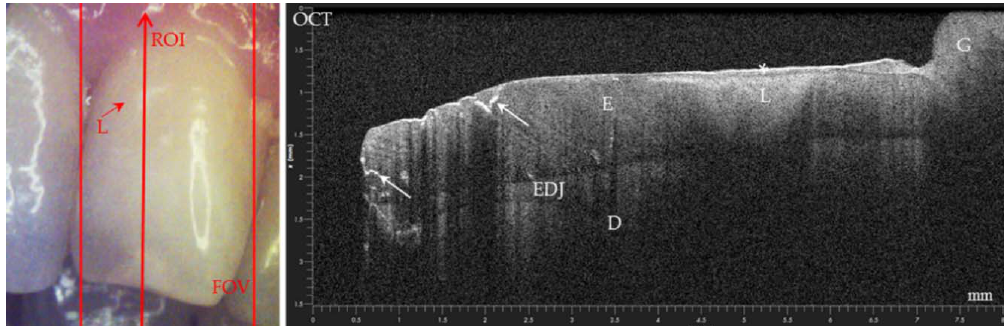
Figure 2. Screenshot, in vivo image of a human incisor. Partial conformance of visual assessment with OCT. A carious lesion (L) of ICDAS II Code 2 can be detected visually at the air ‐ dried enamel surface (red arrow). In the SD ‐ OCT B ‐ scan, this lesion appears as a bright shadowed area without cavitation. Compared to visual assessment, the OCT signal reveals an extended lesion body with dentin (D) involvement and a mineral ‐ rich and porous surface layer (*). In addition, defects, or cracks in the enamel (E) are seen to cause shadowing (white arrows). G: gingiva, EDJ: enamel ‐ dentin junction.